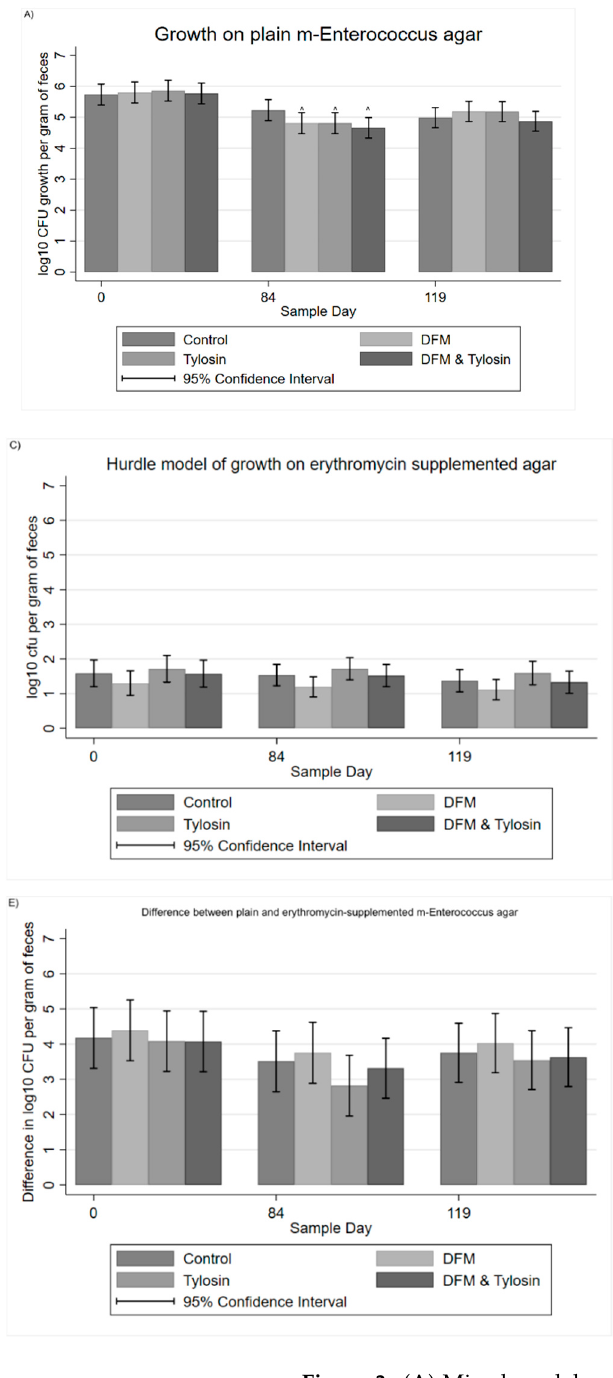
Figure 3. ( A ) Mixed-model marginal mean log 10 CFU per gram of feces on plain m- Enterococcus agar, ^ significantly different from respective treatment groups on Day 0; ( B ) mixed model difference in log 10 CFU between plain and tetracycline-supplemented m- Enterococcus agar; ( C ) Cragg hurdle model estimates of log 10 CFU per gram of feces on erythromycin-supplemented m- Enterococcus agar; ( D ) mixed model estimated differences in log 10 CFU between plain and erythromycin-supplemented m- Enterococcus agar from Replicate 1, ^ significantly different from respective treatment group on Day 0 * significantly different from other treatment groups on Day 84, and ( E ) mixed model estimated differences in log 10 CFU between plain and erythromycin-supplemented m- Enterococcus agar from both replicates.